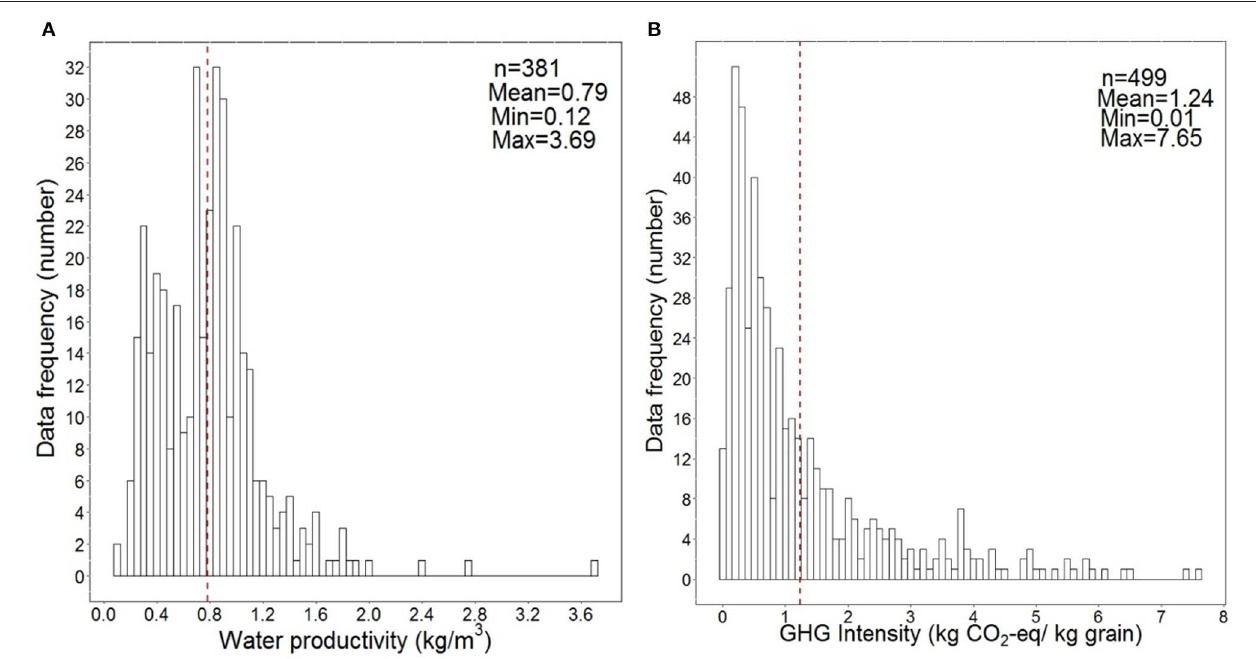
FIGURE 1 | Frequency distribution of Greenhouse Gas intensity (kg CO 2 -eq/kg grain, A ) and Water Productivity (kg/m 3 , B ) data points from reviewed studies. Red dotted line indicated the average of the dataset.